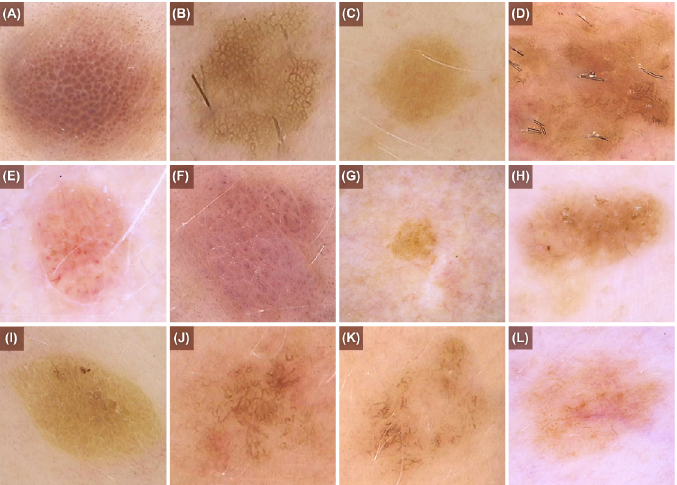
Fig 1. Examplesof naevi in the new BNMS classificationgroups: (a) globular,(b) reticular, (c) homogenous and (d) complex. Examplesof structures that could be mistaken for globules:(e, f) red dots are blood vessels, not pigmentglobules, (g) dots are too small to be globulesand (h, i) yellow structures are keratin, not pigment globules. Examplesof structures that could be mistaken for reticular: (j, k) lines do not form a completenet, so these naevi are complex not reticular; (l) chaotic appearance with widespread structures that are not reticular or